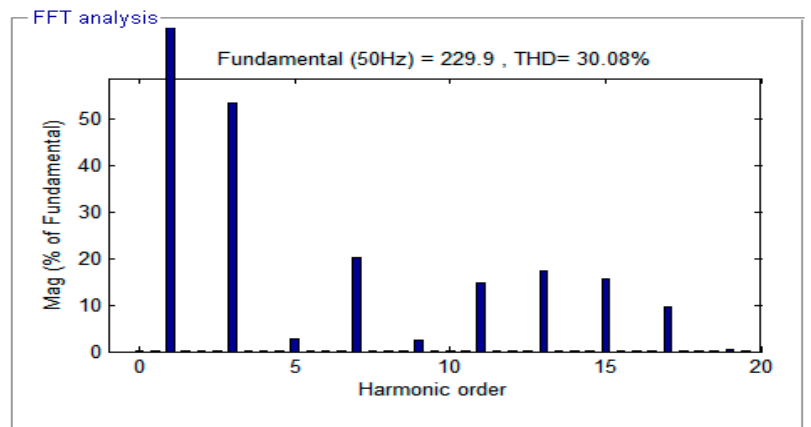
Figure 17. TLBDCLCHB inverter output using EPCAD technique.